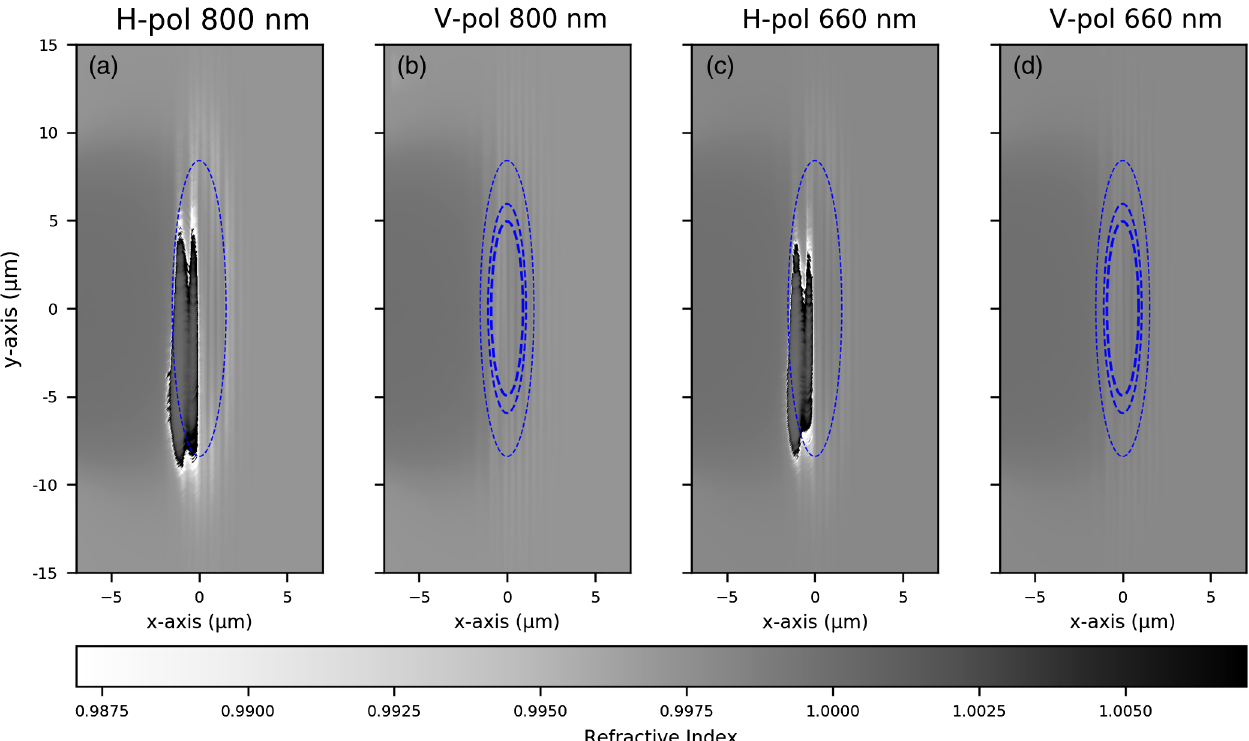
FIG. 8. Refractive index of the plasma in the xy plane for different probe polarizations and wavelengths induced by a pump pulse with a 6.0 fs FWHM duration and an a 0 of 5.0. The blue, dashed lines represent the FWHM, 1 = e and 1 = e 2 intensity contours of the Gaussian pump pulse. Note that in both H-pol subplots the two inner contour lines have been omitted as to not block visibility of the asymmetric signal. Each subplot of the figure is labeled with the probe beam ’ s polarization (H-pol or V-pol) and its wavelength (800 or 660 nm). The figures are calculated from data produced from VS im in simulating the xy